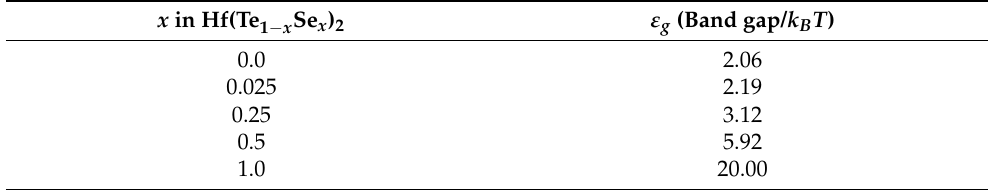
Table 1. The ε g for Hf(Te 1 − x Se x ) 2 ( x = 0.0, 0.025, 0.25, 0.5, and 1.0) at 300 K [22].